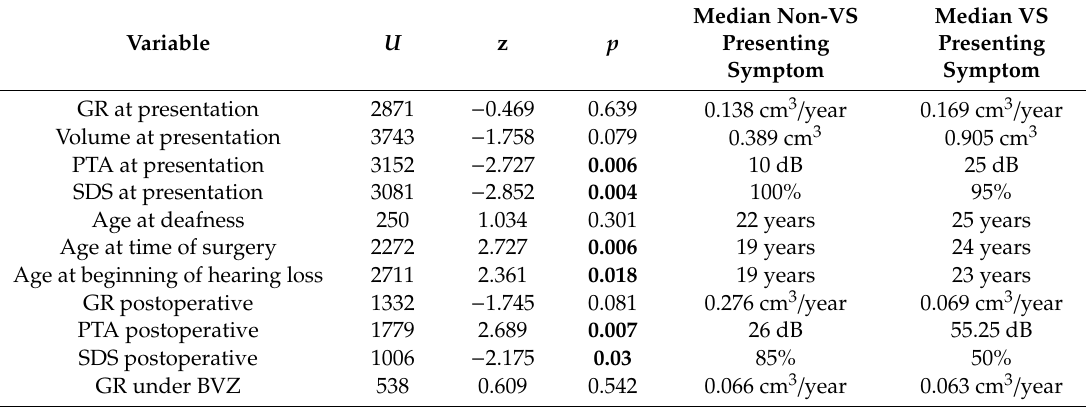
Table 5. Di ff erence in VS related parameters between patients with VS related and with non-VS related presenting